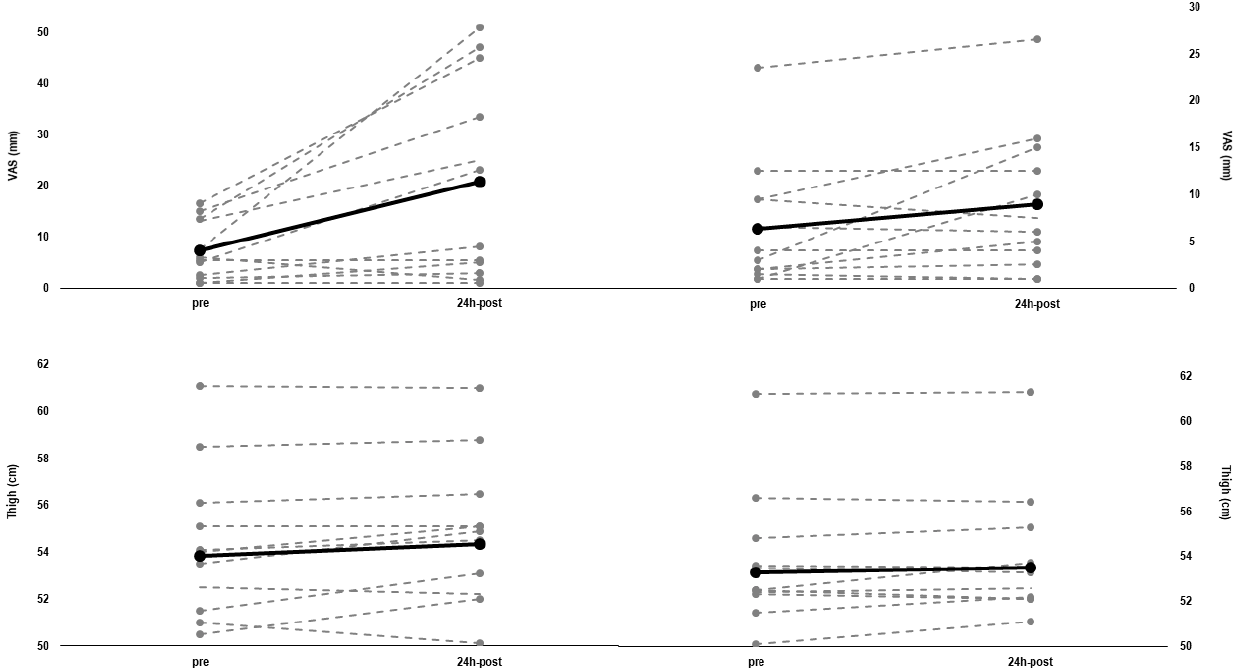
Figure 4. Individual values ( n = 12) and mean values (solid line) for visual analogue scale (VAS) and thigh circumference from baseline (pre), to 24 h after (24 h-post) eccentric cycling (left panel) and concentric cycling (right panel).